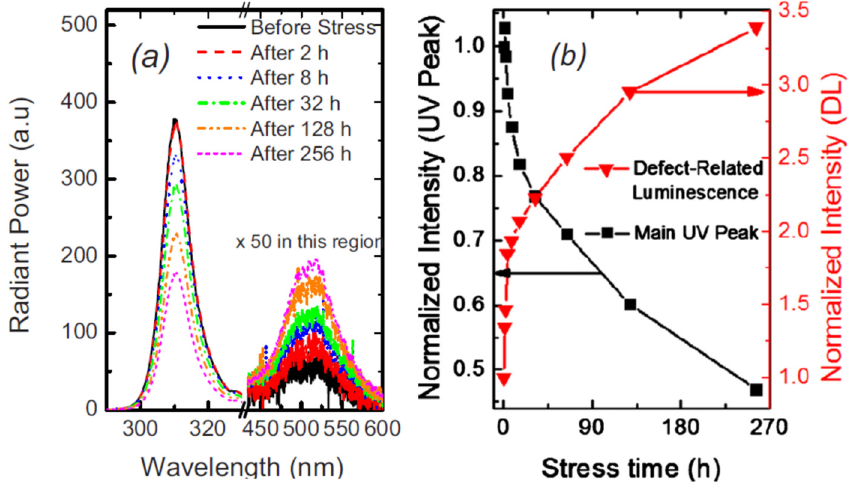
Figure 14. ( a ) EL spectra with stress at 17 A/cm 2 , RT. ( b ) Variation in the intensity of peaks under stress. Reproduced with permission. [62] Copyright 2010, AIP.